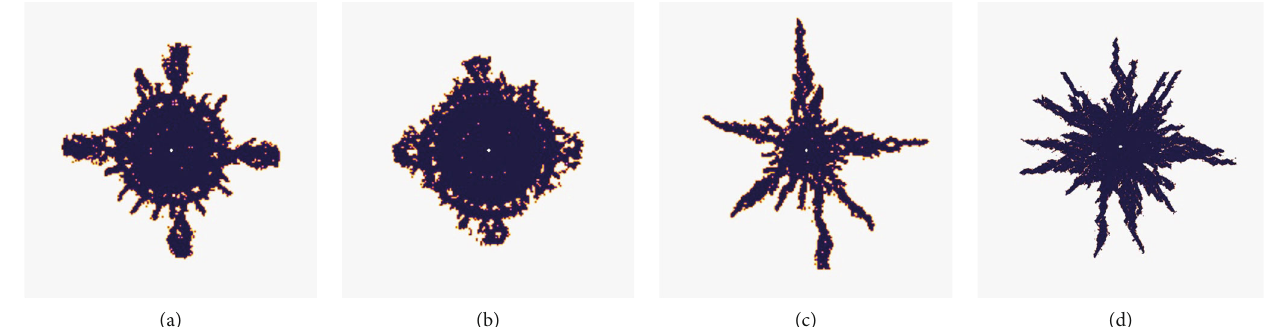
Figure 7: Distribution of damaged area in the CwM method and proposed method at 5 min. (a) CwM, Δ t = 1 min ; (b) CwM, Δ t = 0 : 5 min ; (c) CwM, Δ t = 0 : 1 min ; and (d) proposed method, H d